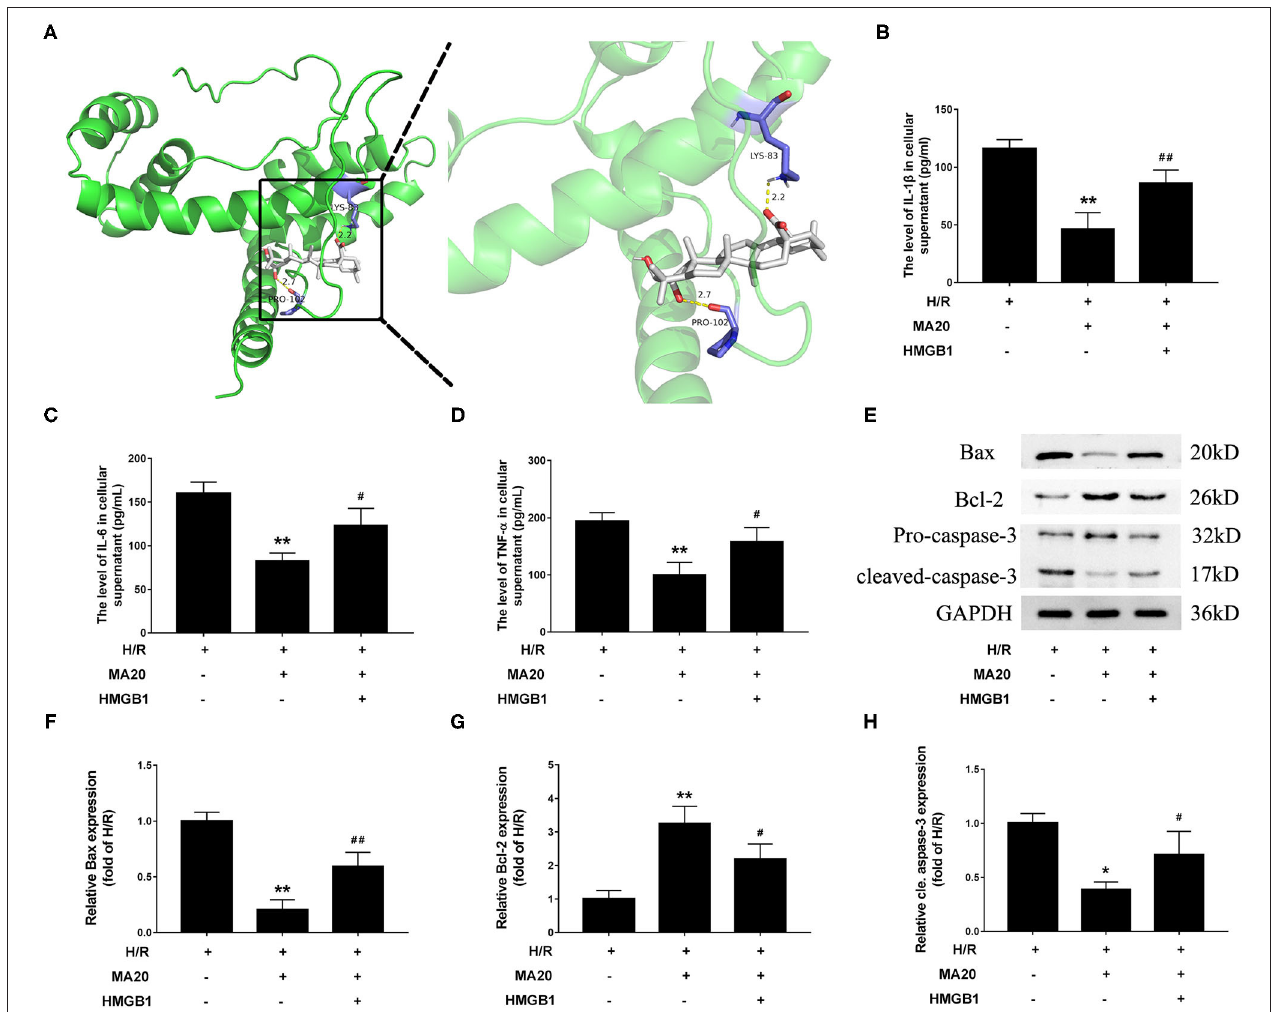
FIGURE 5 | Maslinic acid attenuated H/R-induced inflammation and apoptosis via regulating HMGB1. (A) Final three-dimensional homology structure predictions of the docking conformation between MA and HMGB1. The sticks are shown for catalytic residues LYS-83 and PRO-102 (purple). The hydrogen bond (dashed yellow lines) distances are 2.2 and 2.7. (B–D) After pretreated with 20 µ M of MA or plus rHMGB1, the levels of IL-1 β , IL-6 and TNF- α in culture medium were assessed by the specific ELISA analyses under H/R conditions. (E) Western blot was performed to assess the expression of apoptosis-related proteins (Bax, Bcl-2, and cleaved caspase-3) in H9c2 cell under H/R conditions. (F–H) The quantitative analysis of the apoptosis-related proteins is shown in bar graphs. All the values are representative of at least three independent experiments and expressed as the mean ± SD. * P < 0.05 and ** P < 0.01 vs. H/R group; # P < 0.05 and ## P < 0.01 vs. H/R + MA20